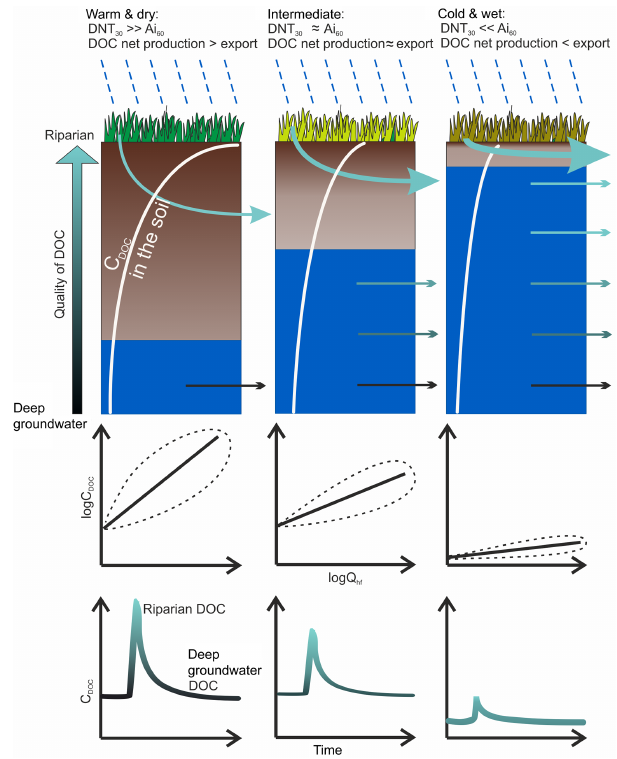
Figure 6. Conceptual model of riparian DOC export from precip- itation during the three hydroclimatic states: warm and dry, inter- mediate, cold and wet. Depth of the soil column is around 0.5m. Seasonal-scale variations in C DOC in the soil solutions (summer vs. winter) were discussed in Kalbitz et al. (2000). Changing com- binations between SUVA 254 and S 275 − 295 values are described as more groundwater-influenced (black) and more riparian-influenced (green) DOC quality. Arrows indicate the export of DOC; colors of the arrows refer to the respective DOC quality. Panels in the mid- dle row show the relation between C DOC and Q hf during the three representative situations. Dashed lines indicate the “dispersion” of the point cloud (according R 2 ) during the events. Panels in the bot- tom line indicate the change of C DOC during an event. Correspond- ing changes of colors indicate more groundwater-influenced (black) and more riparian-influenced (green) DOC quality. Baseflow levels under cold and wet conditions are usually higher than baseflow lev- els during the warm and dry phase (see Fig. 5). Thus, during the cold and wet situation, higher layers of soil, more enriched in DOC, are activated, but at the same time, there is also a tradeoff between amount of water and available DOC in the respective soil layers which can account for lower overall DOC